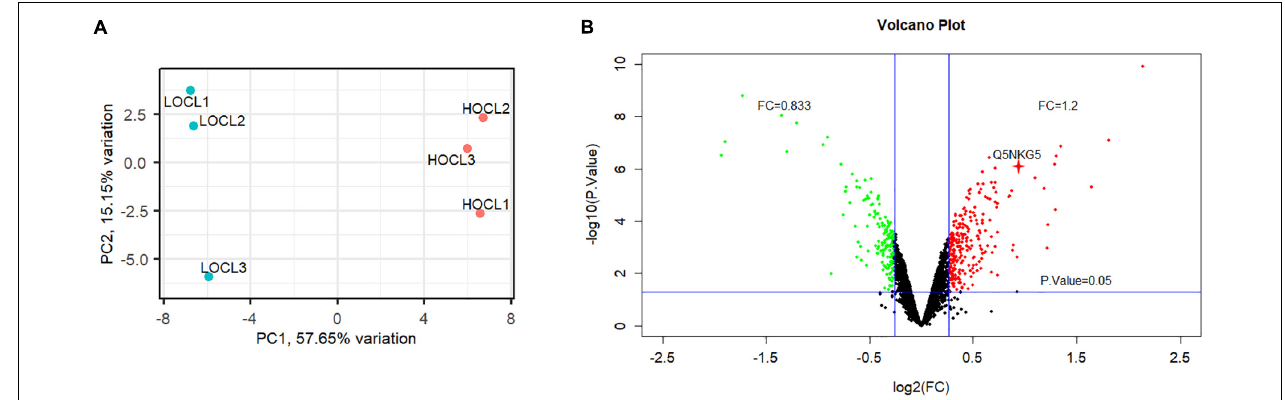
FIGURE 2 | Principal component analysis and volcano plot of the proteome in seeds of HOCL and LOC. (A) Principal component analysis of the proteome in seeds of HOCL and LOCL. Percentages (%) indicate the percentage of overall variance captured by each principal component. PC1: principal component 1; PC2: principal component 2. (B) Volcano plot of DAPs between the seeds of HOCL and LOCL. Threshold cutoff ( > 1.2 or < 0.83) determined for log2 fold change ratios are represented by two vertical blue lines. Adjusted p -value cutoff of 0.05 is represented by a horizontal blue line. Red dots represent up-accumulated proteins, and green dots indicate down-accumulated proteins, whereas back dots represent proteins that do not meet the threshold or adjusted p -value, in HOCL compared to LOCL. The red cross indicates BnLEA57